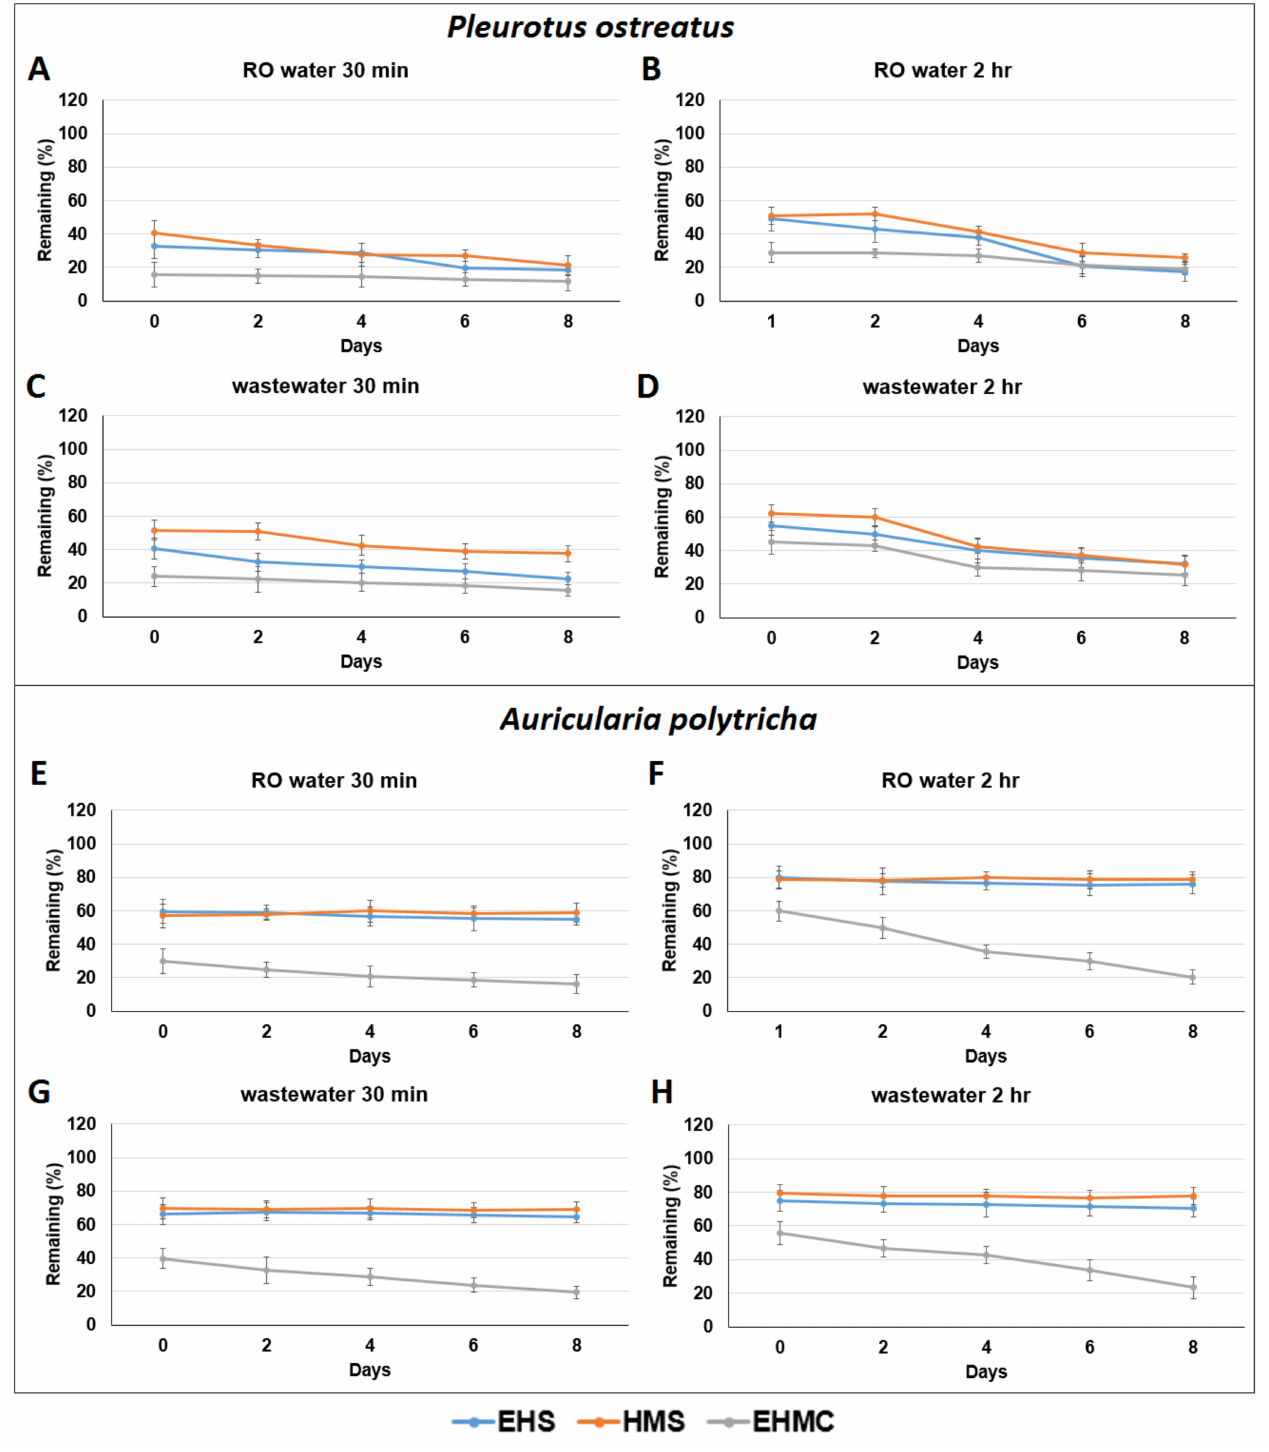
Figure 8. Bioreactor experiments simulating UV filter (20 ppm) removal in reverse osmosis (RO) filtration ( A , B , E , F ) and wastewater ( C , D , G , H ) using the spent mushroom compost of two mushrooms ( Pleurotus ostreatus ( A – D ) and Auricularia polytricha ( E – H )). Data from triplicate experiments are presented as the mean ± SE. EHMC: ethylhexyl methoxycinnamate, EHS: 2-ethylhexyl salicylate, HMS: